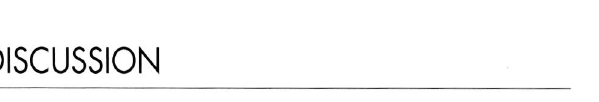
At the tenth passage without chloroquine, D2% was 4.64 days (i.e. very closely related to the initial value: 4.34